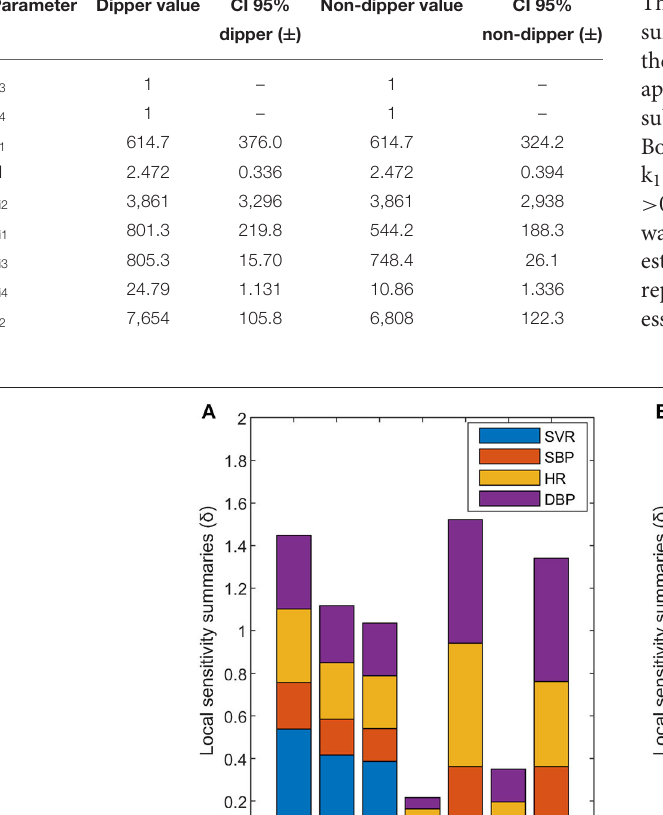
TABLE 1 | Estimated parameters for dipper and non-dipper subjects. Parameter Dipper value